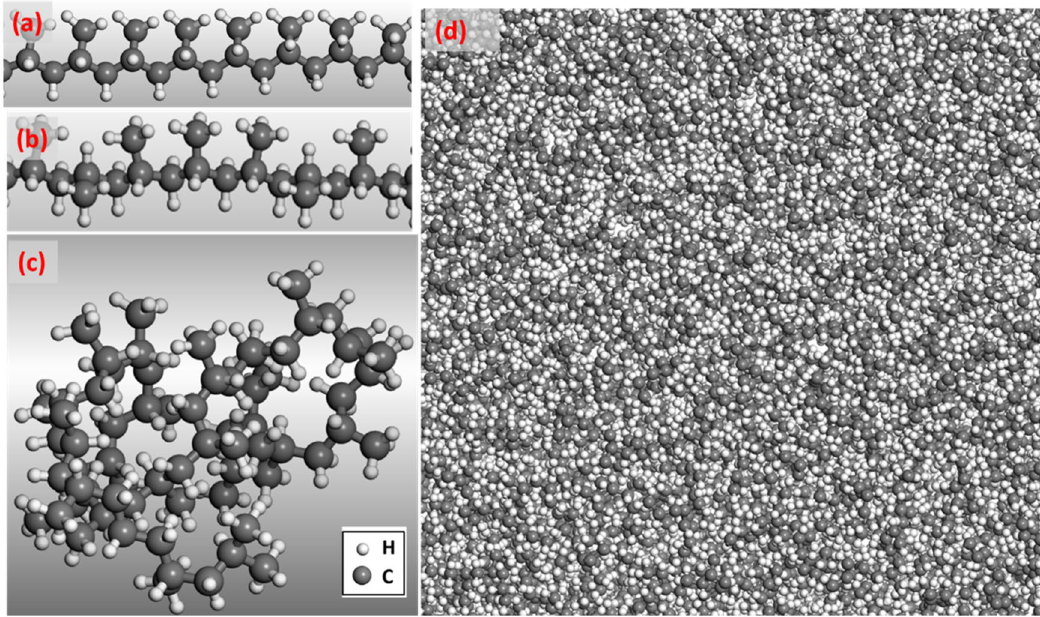
Figure 1. The atomistic model for PP matrix. An isotactic ( a ) and an atactic ( b ) segment of a PP chain. A single PP chain ( c ) taken out of an amorphous PP matrix ( d ). The mass density of the amorphous PP matrix ρ = 0.9 g/ cc at room temperature. Carbon atoms are grey and hydrogen atoms are white. The BIOVIA Materials Studio 2020 VERNO 20.1.0.2728 (https:// www. 3ds. com/ produ cts- servi ces/ biovia/ produ cts/ molec ular- model ing- simul ation/ biovia- mater ials- studio) was used to create the drawings in the figure.